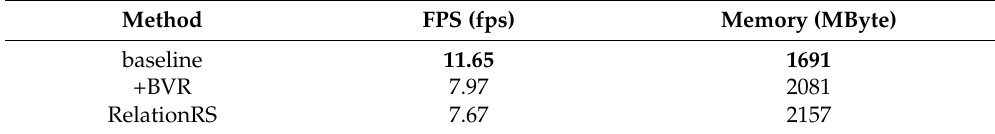
Table 4. The inference speed (frames per second, FPS) and graphics processing unit memory occu- pancy of the method proposed in this paper. Bold numbers indicate the best value in that column.